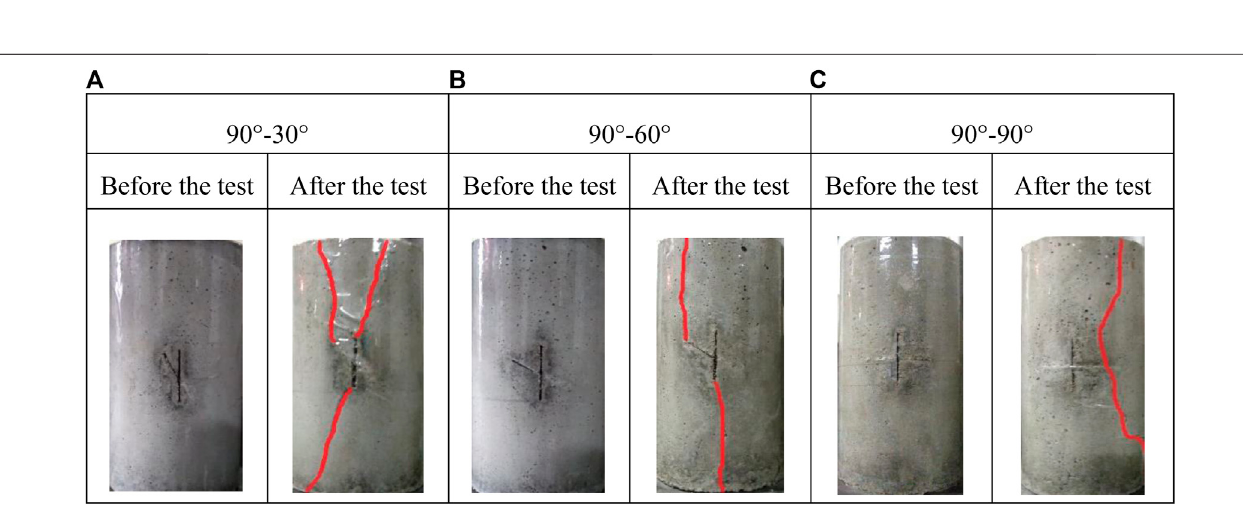
Frontiers in Earth Science |